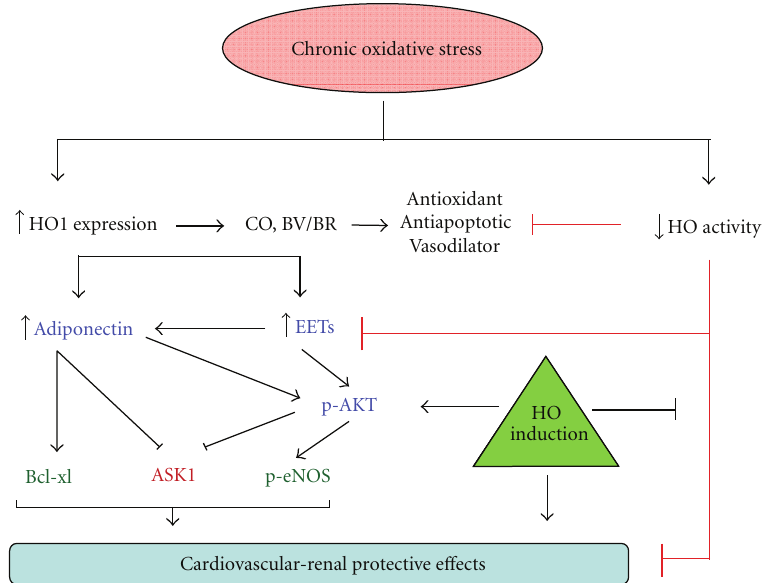
Figure 5: The schematic outlines the salient points discussed in the paper. Chronic oxidative stress upregulates HO-1 expression whose products, CO & BV have antioxidant properties and help restore redox homeostasis. In addition, HO induction stimulates epoxide synthesis and these pathways combined enhance adiponectin release. Antioxidant, antiapoptotic, vasomodulatory, and renoprotective properties of HO-EET-adiponectin axis restore cardiovascular-renal homeostasis often disrupted in conditions of oxidative stress. HO induction overcomes a concurrent inhibition of HO activity by redox-dependent mechanisms which o ff set the protective e ff ects of enhanced HO expression thus contributing towards pathophysiological abnormalities observed in conditions of chronic oxidative